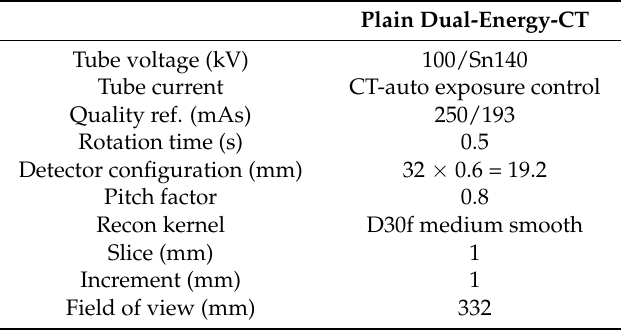
Table 1. DECT examination